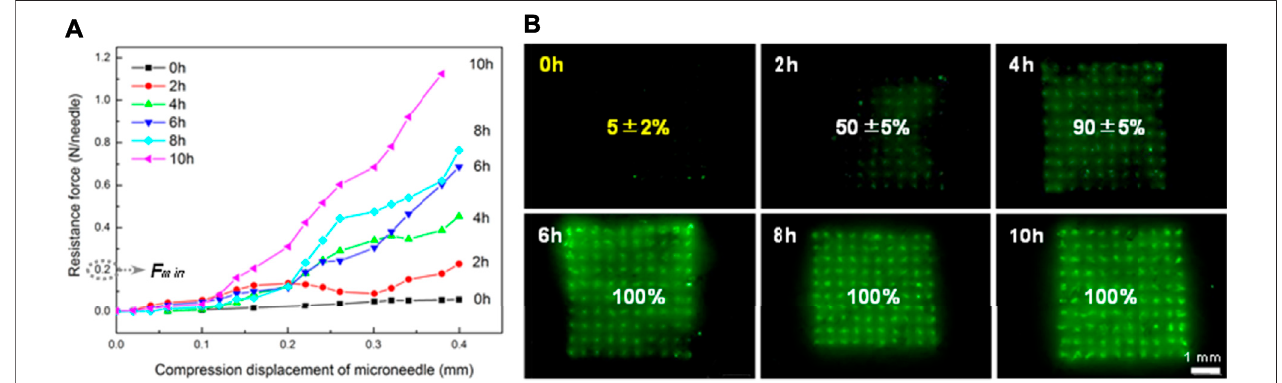
FIGURE4| Resultsofcompressiontest forFITC-labeled MNwithdifferentdrying time (A) andpenetrationratioofinsertingcorrespondingFITC-labeled MNarrays into porcine skin successfully (B) .